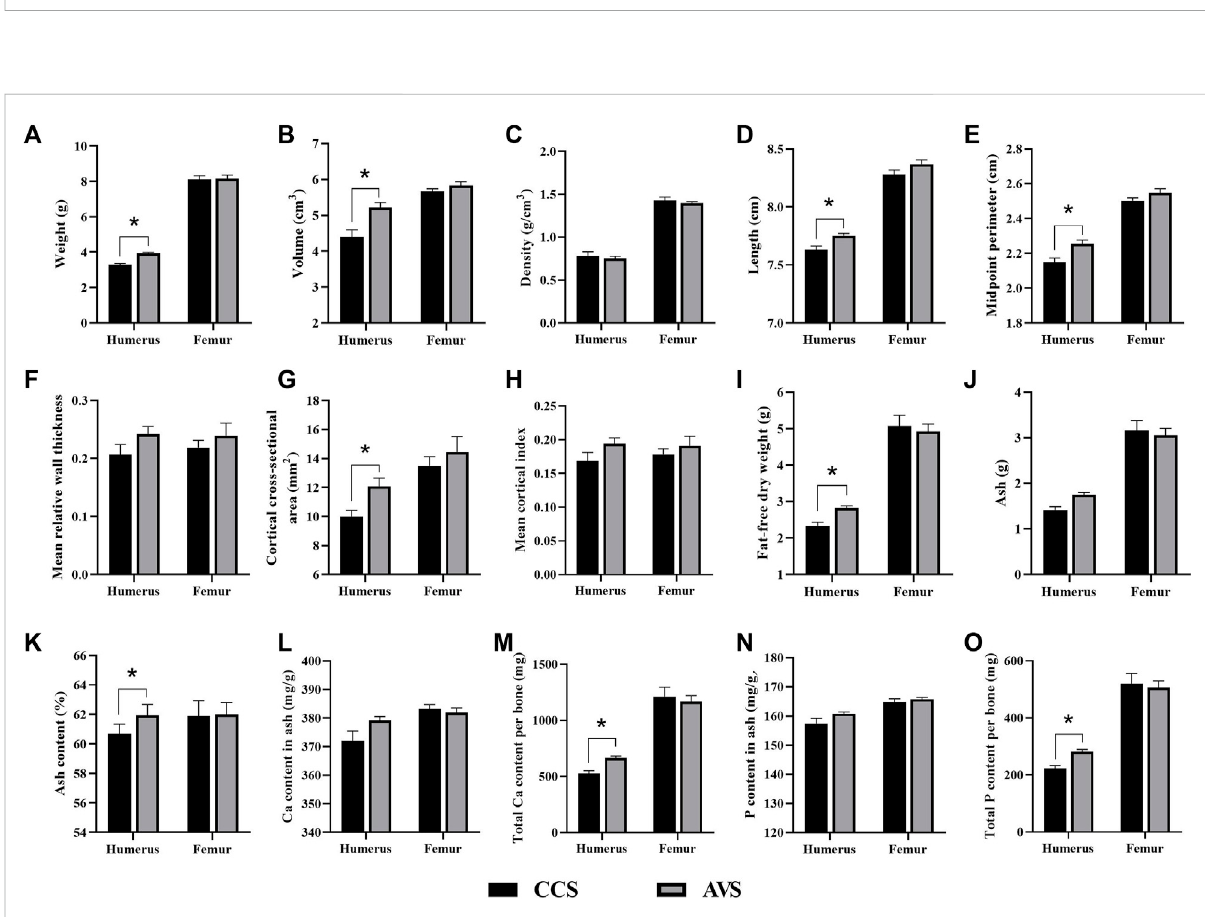
FIGURE 3 Effect of rearing systems on bone geometric characteristics (A – H) and component (I-O) in the aged laying hens (95 weeks of age) (n = 6). (A) Bone weight, (B) Volume, (C) Density, (D) Length, (E) Midpoint perimeter, (F) Mean relative wall thickness, (G) Cortical cross-sectional area, (H) Mean cortical index, (I) Fat-free dry weight, (J) Ash, (K) Ash content, (L) Ca content in ash, (M) Total Ca per bone, (N) P content in ash, (O) Total P per bone. CCS, conventional caging system; AVS, aviary system. Data represent means with standard error. * p <